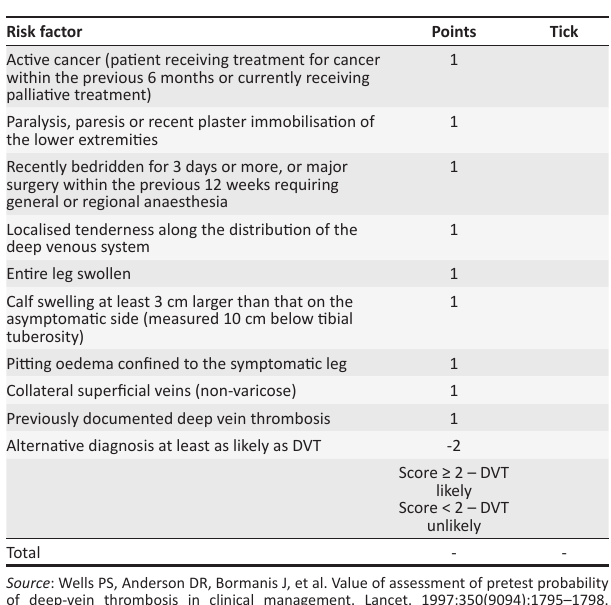
FIGURE 1-A1: Modified Wells score for DVT.